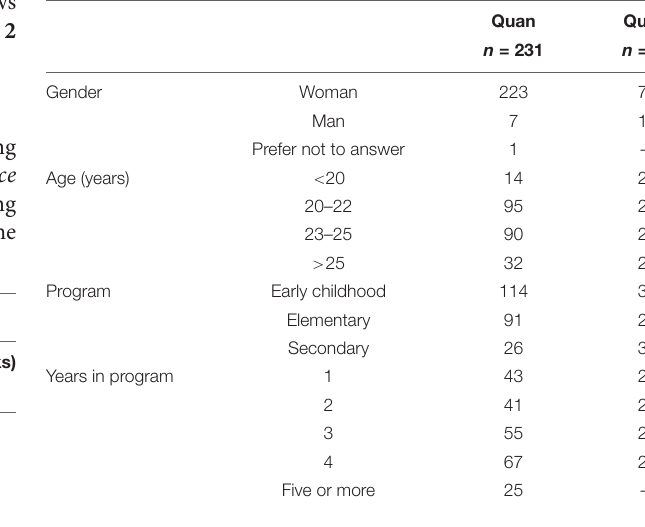
TABLE 2 | Socio-demographic characteristics of the pre-service